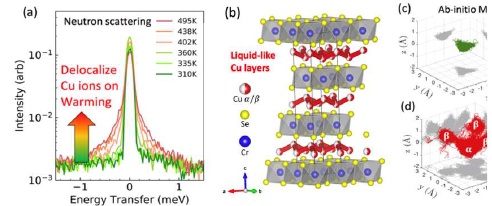
Fig. 10 . (a) Quasi-elastic neutron scattering signal showing delocalization of Cu ions with increasing temperature (broadening of central peak). (b) Layered structure of CuCrSe 2 , showing liquid-like Cu layers in superionic phase above 365 K. (c,d) Ab-initio MD calculations of Cu ion trajectory, showing delocalization across  and  sites at high T (adapted from [58]).